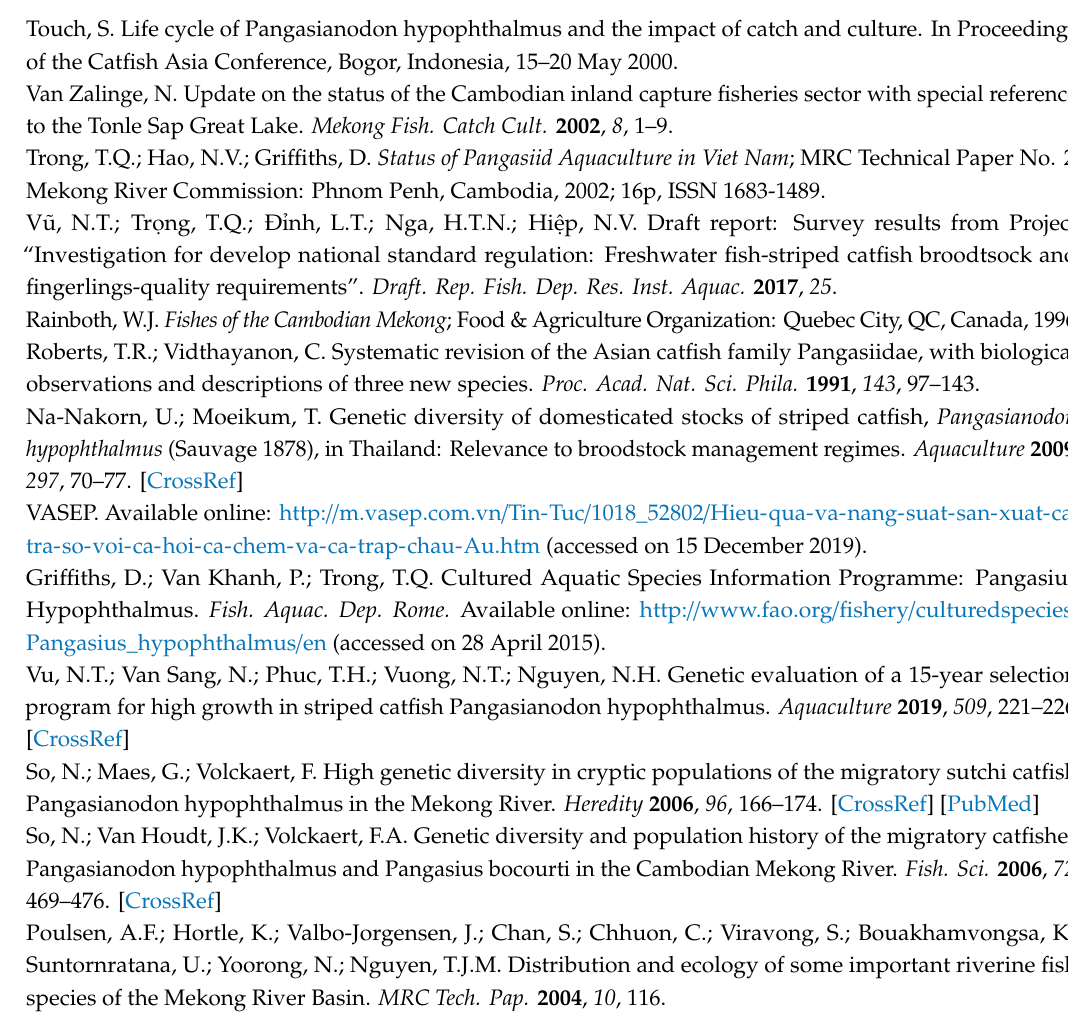
Table S1: Ninety-three samples of striped catfish information based on farm and wild catfish stocks in 4 major pangasius-farming countries, Table S2: Basic statistics about the sequence data, Table S3: Mean allelic pattern across seven catfish stocks based on GenAlEx analyses, Table S4: Historic migration between seven catfish stocks. Author Contributions: All authors conducted the study. T.T.T.H. and V.T.B.T. and V.T.T. collected the